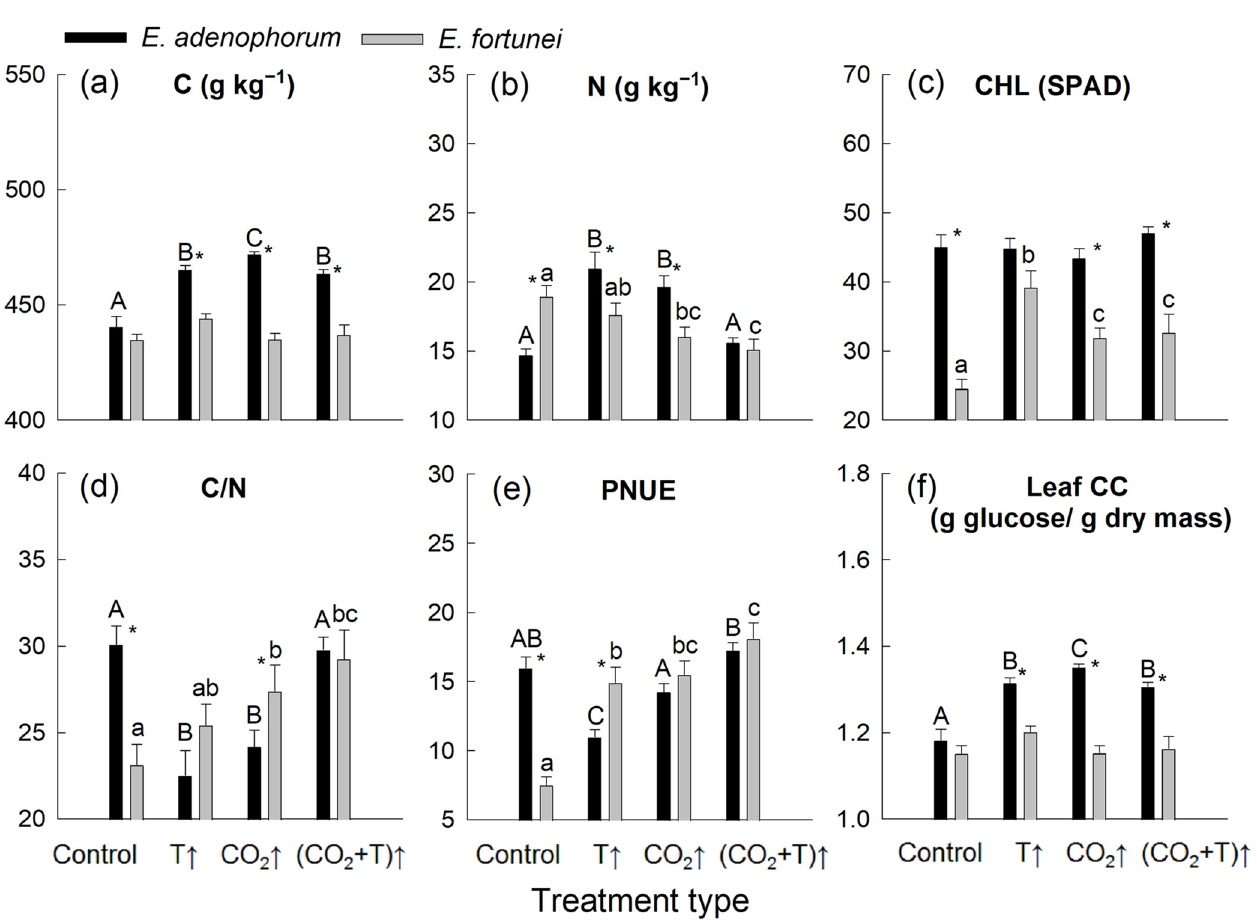
Figure 3. Leaf nutrient concentrations and nutrient relations of an invasive Eupatorium species ( E. adenophorum ) and a native Eupato- rium species ( E. fortunei ) under different treatments: control, elevated temperature (T ↑ ), elevated CO 2 concentration (CO 2 ↑ ), and ele- vated both temperature and CO 2 concentration [(CO 2 + T) ↑ ]. ( a ) Leaf carbon concentration (C); ( b ) leaf nitrogen concentration (N); ( c ) leaf chlorophyll concentration (CHL); ( d ) leaf carbon: nitrogen (C/N); ( e ) photosynthetic nitrogen use efficiency (PNUE); ( f ) leaf con- struction cost (CC). Bars topped by the same letter do not differ significantly between treatment types within the species. Bars topped by * differ significantly between species within the treatment